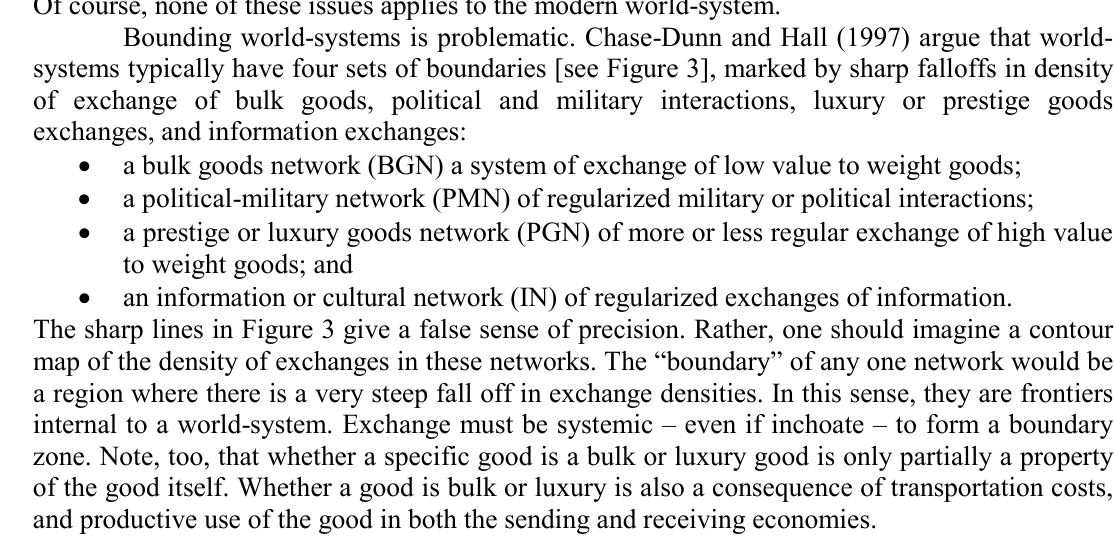
Figure 3: Word-System Networks